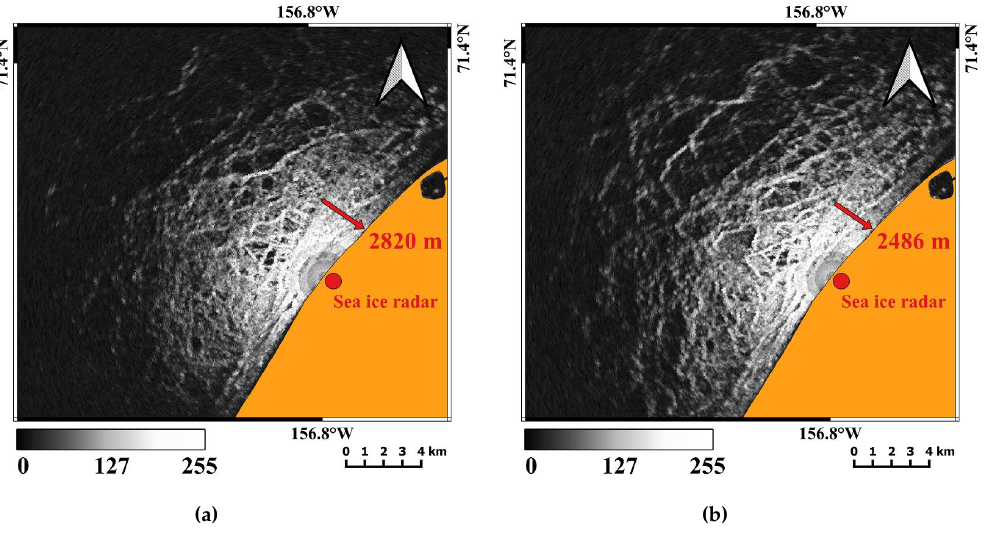
Figure 2. Coastal radar images taken on 13 Jan 2012, 03:18 UTC ( a ) and 24 Jan 2012, 03:18 UTC ( b ). Images indicate compression towards the coast during the time period spanned by the two dates. Red arrows indicate one example where a ridge has been displaced towards the coast. Land is masked out in orange.